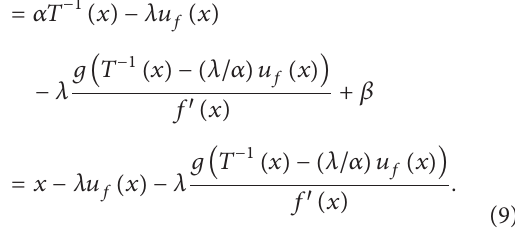
𝜆 = 0.5 , where the BZ interval is